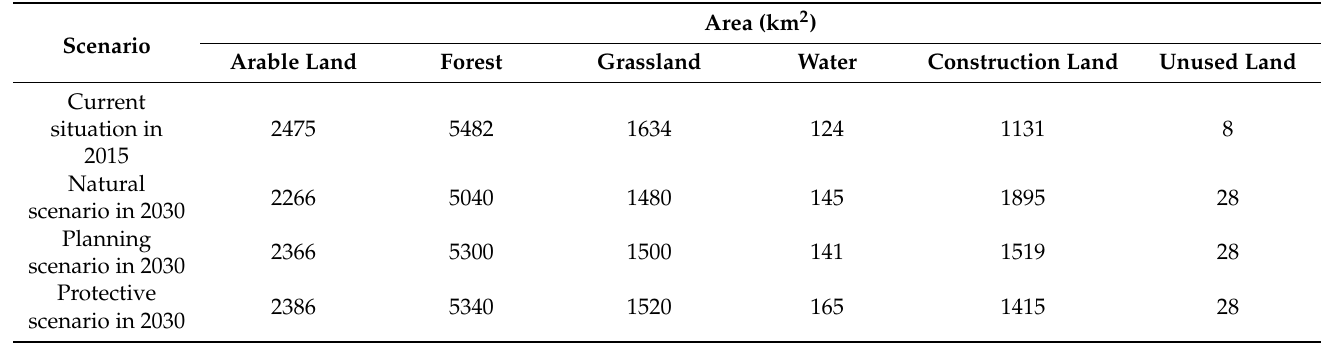
Table 5. Land use area in Quanzhou in 2030 under different scenarios.